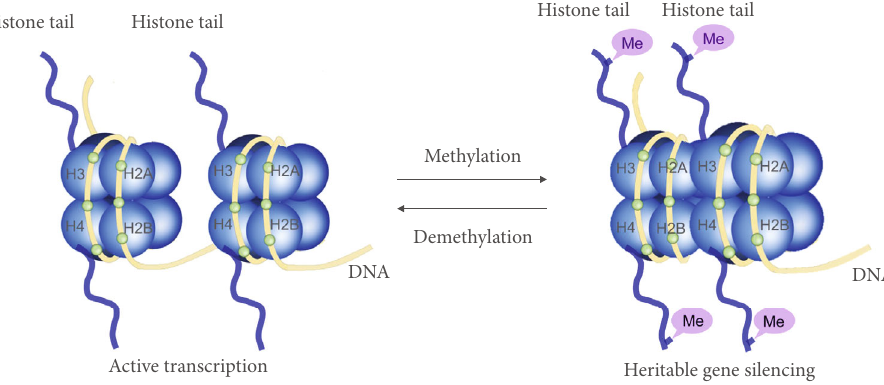
Figure 4: Schematic representation of histone methylation and demethylation. DNA twines on histone proteins, including two dimers, H3/ H4 and H2A/H2B, all of which compose a globular histone octamer and form the basic units of chromatin as nucleosomes. Histone methylation mainly occurs at arginine and lysine residues of the tail in H3/4 and is mediated by methyltransferases and histone demethylation is regulated by demethylases. Histone methylation can a ff ect the spatial structure of chromatin by a ff ecting the structure of nucleosomes and thus regulating the expression activity of genes. The nucleosome structure usually becomes crowded by adding methyl group (Me) from arginine and lysine residues of the tail, which making it di ffi cult for gene segments to be transcribed, so gene expression is silenced. In contrast, the demethylation of histone usually could induce the open histone structure by removing methyl group (Me) from arginine and lysine residues of the tail, which expose the transcription factor binding sites and regulates the transcriptional activation of